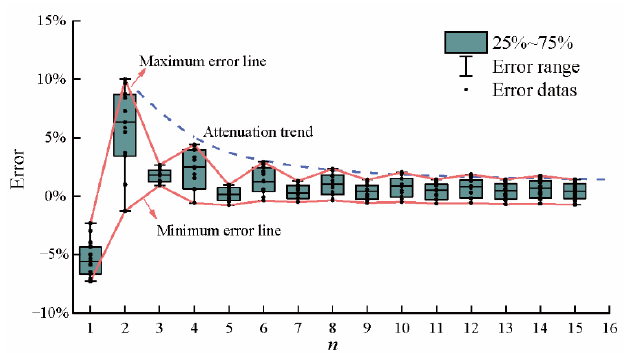
Figure 15. Error results ( d 7 = 0.3 m).